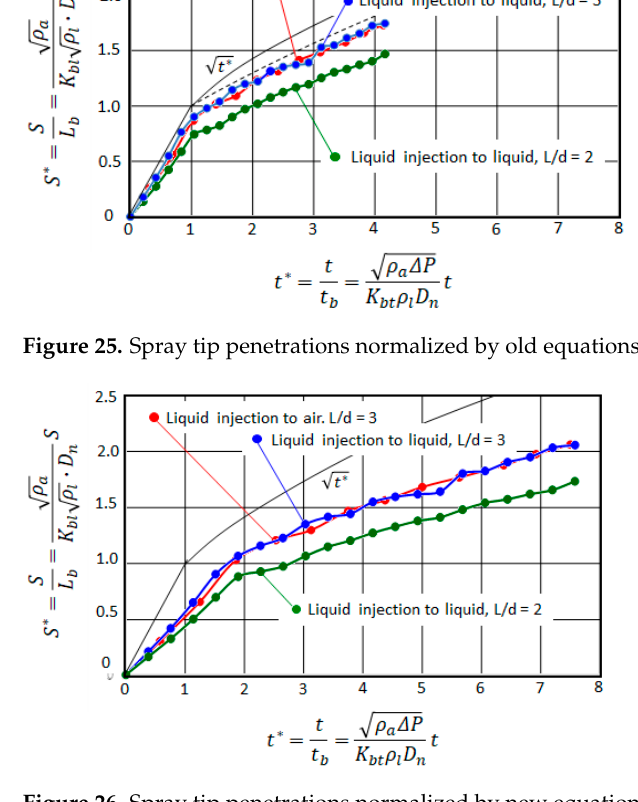
Figure 26. Spray tip penetrations normalized by new equations and coefficients.